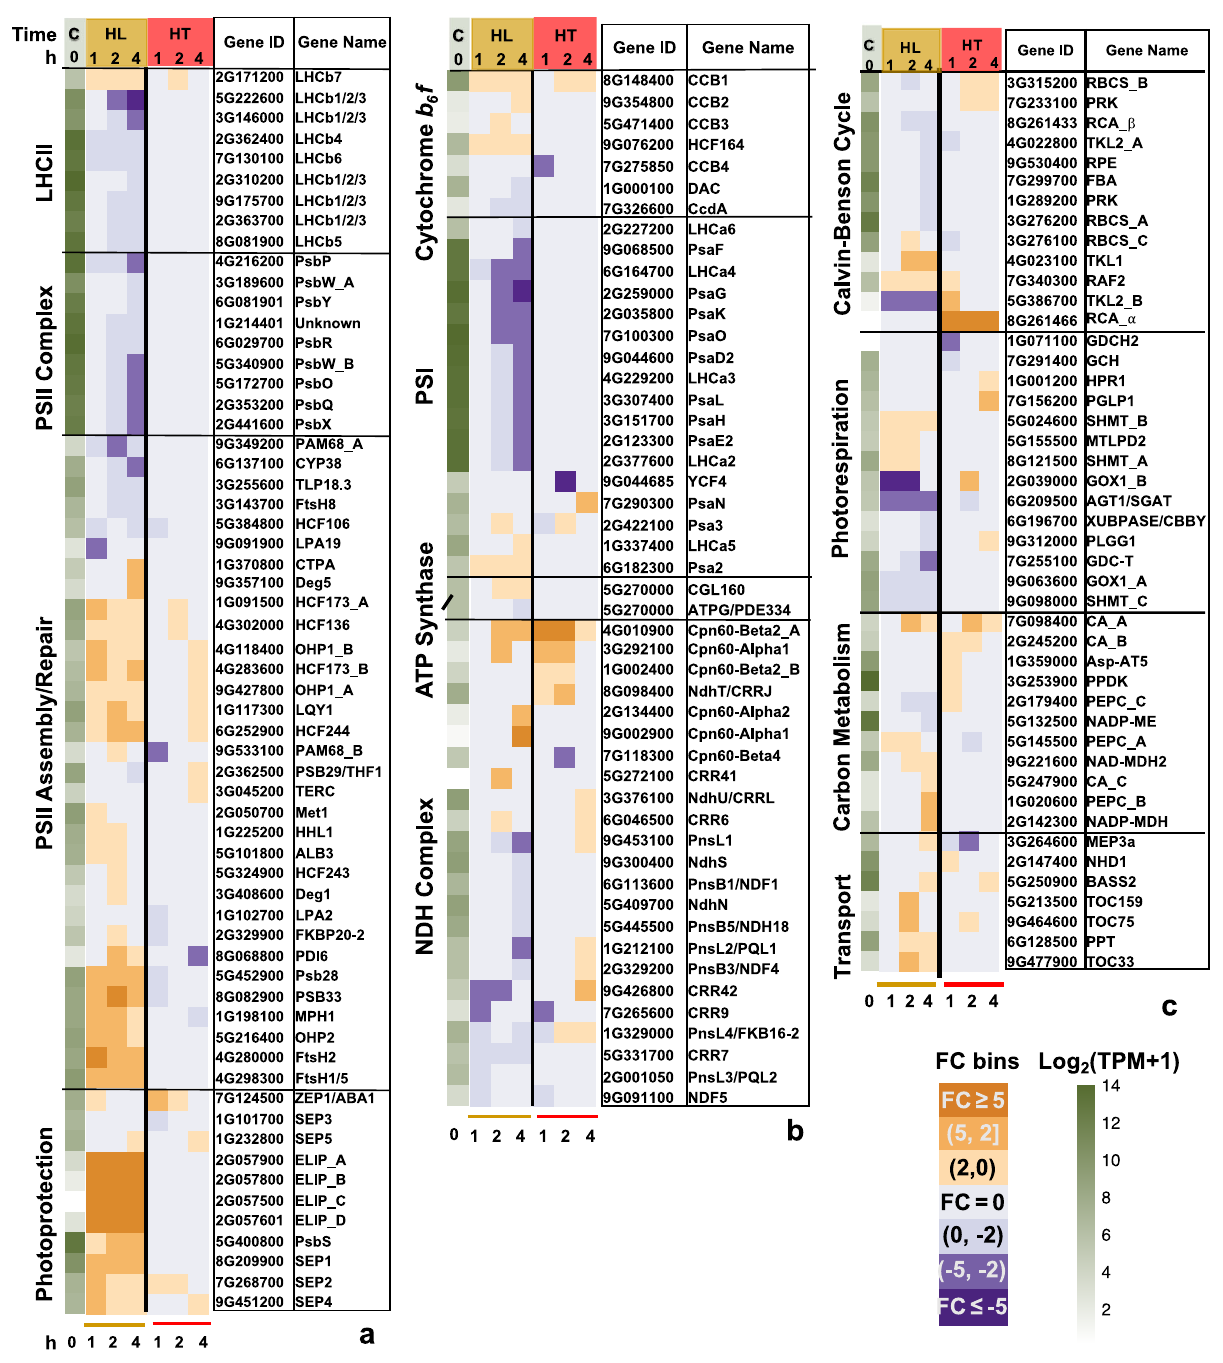
Fig. 3 High light differentially regulated genes involved in photosynthesis more than high temperature. a , b Genes related to light reaction of photosynthesis and photoprotection. c Genes related to carbon metabolism and chloroplast transport. The fi rst green column displays log 2 (mean TPM + 1) at ctrl_0h (at the start of treatments, C). TPM, transcripts per million, normalized read counts. Heatmap displays the fold change (FC) bin of DeSeq2 model output values at 1, 2, and 4 h of high light or high temperature versus control at the same time point ( q < 0.05). FC bins: highly induced: FC ≥ 5; moderately induced: 5 > FC ≥ 2; slightly induced: 2 > FC > 0; not differentially expressed: FC = 0; slightly repressed: 0 > FC > − 2; moderately repressed: − 2 ≥ FC > − 5; highly repressed: FC ≤ − 5. Gene ID: S. viridis v2.1 gene ID, excluding “ Sevir ” . All genes presented in the heatmaps were signi fi cantly differentially regulated in at least one time